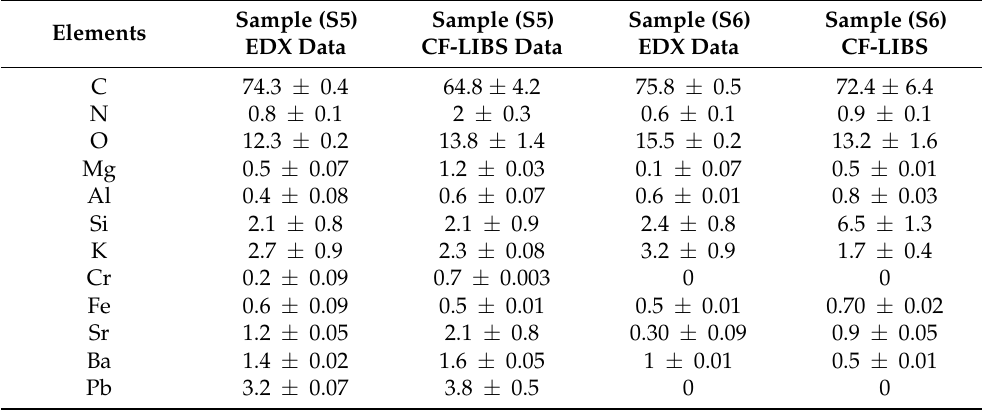
Table 5. The constituents concentrations of elements in C. longa (turmeric powder) samples are jus- tified by EDX and CF-LIBS. justified by EDX and